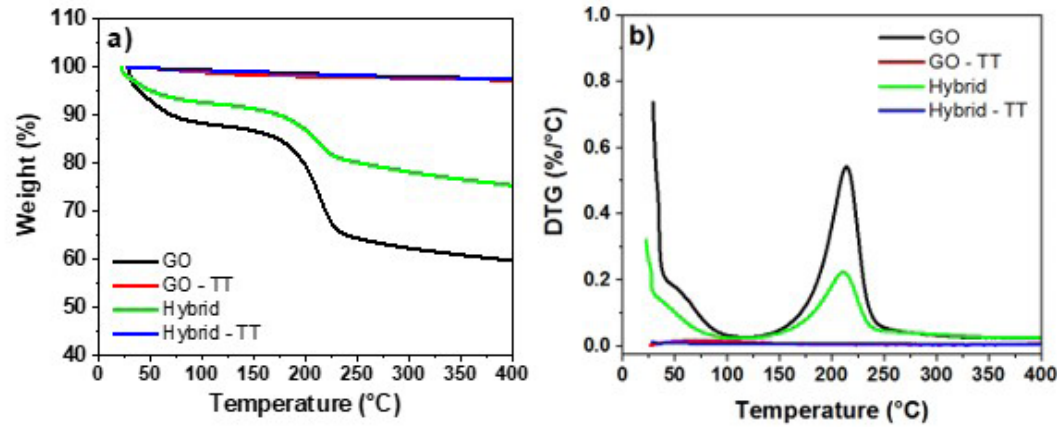
Figure 6. TGA ( a ) and DTG ( b ) curves of the pure GO and hybrid paper-likes untreated and treated thermally (TT) obtained at 10 °C min -1 in a nitrogen